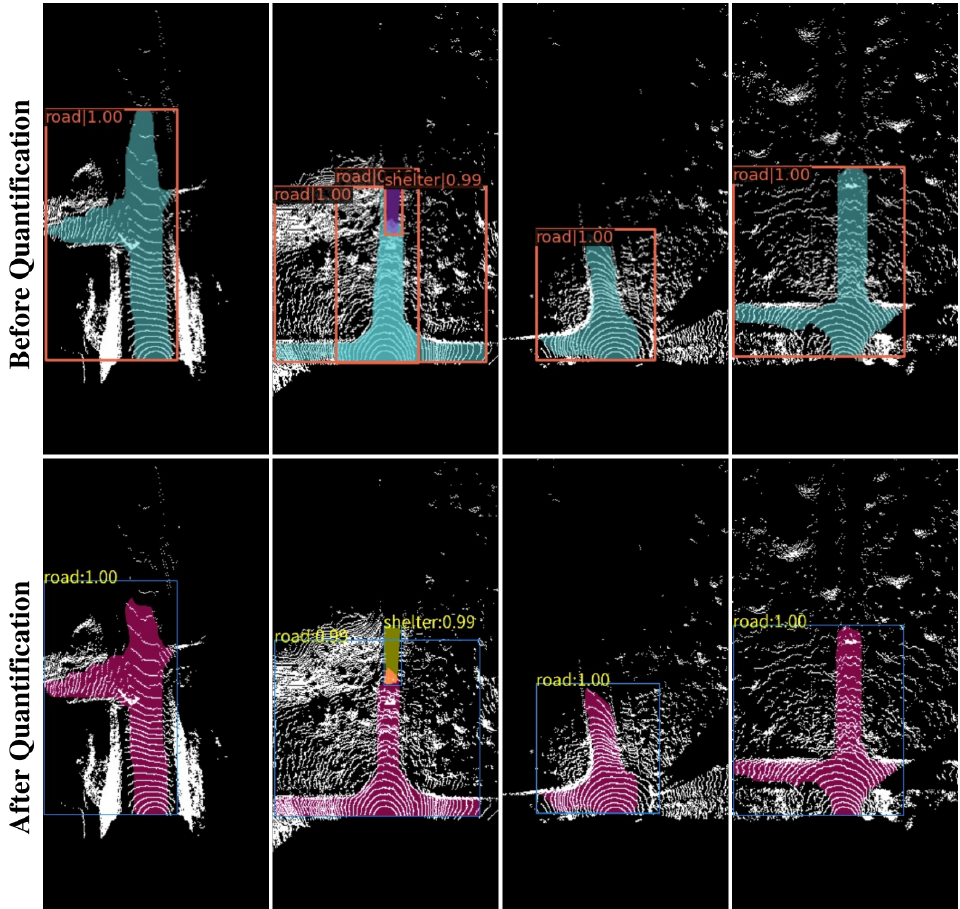
Figure 14. The results before and after quantification. The upper row of images is the result before quantization, and the lower row is the result after